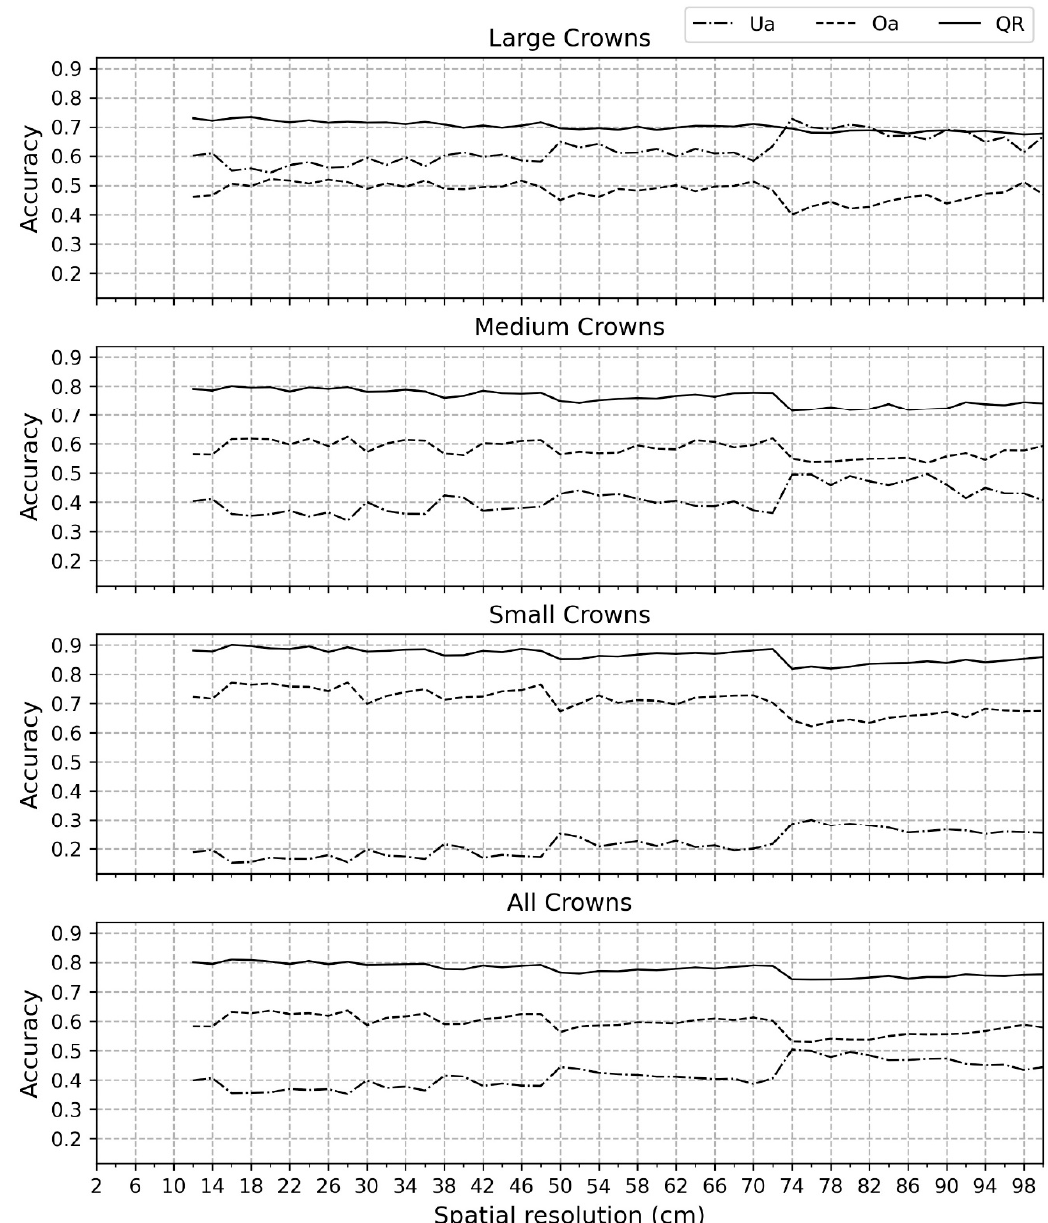
Figure 3. Impact of spatial resolution and crown size on Oa, Ua, and QR using the canopy height model (CHM) in study site #1.